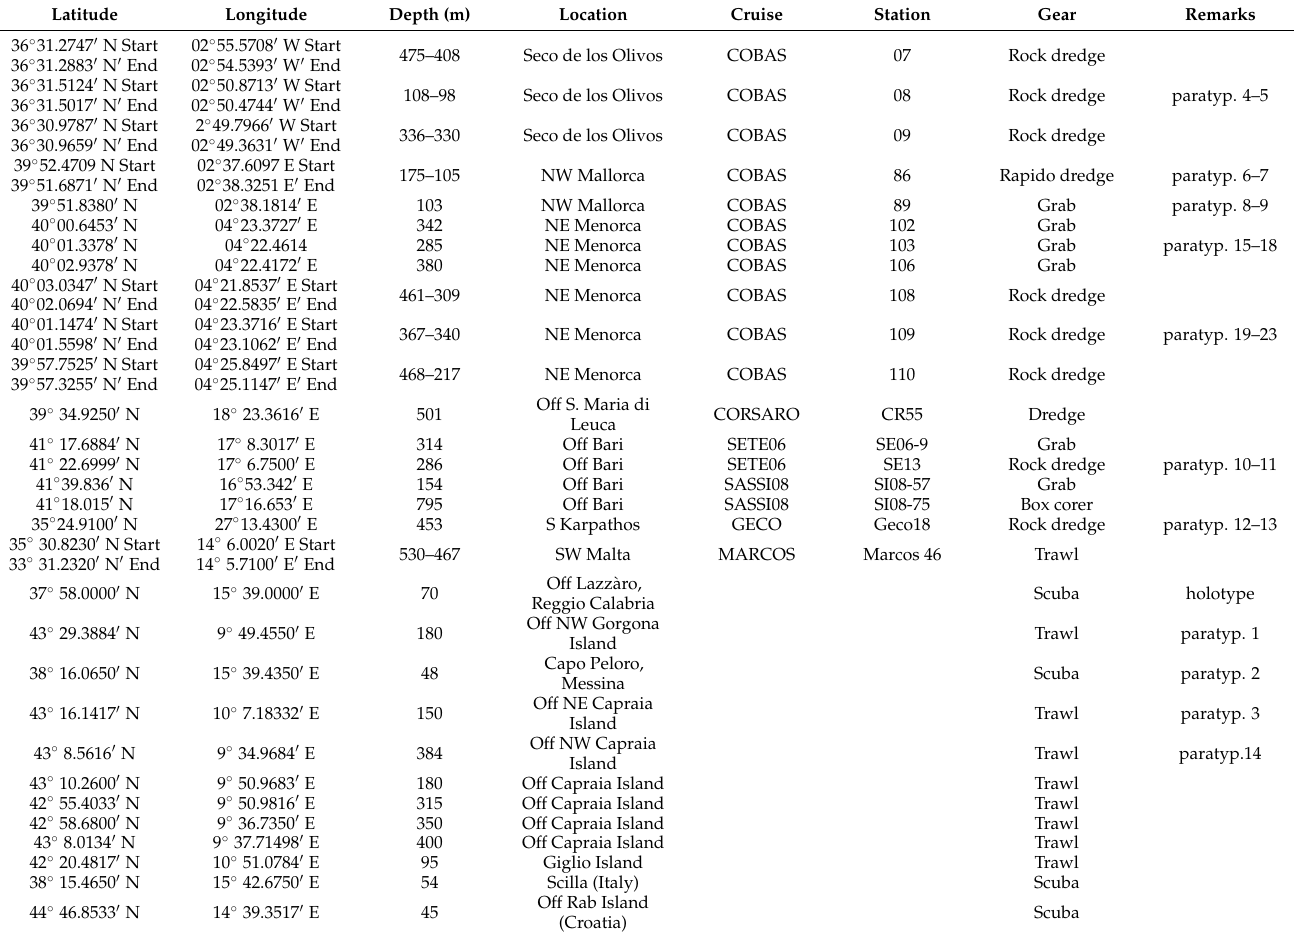
Table 1. Stations providing the material considered in this